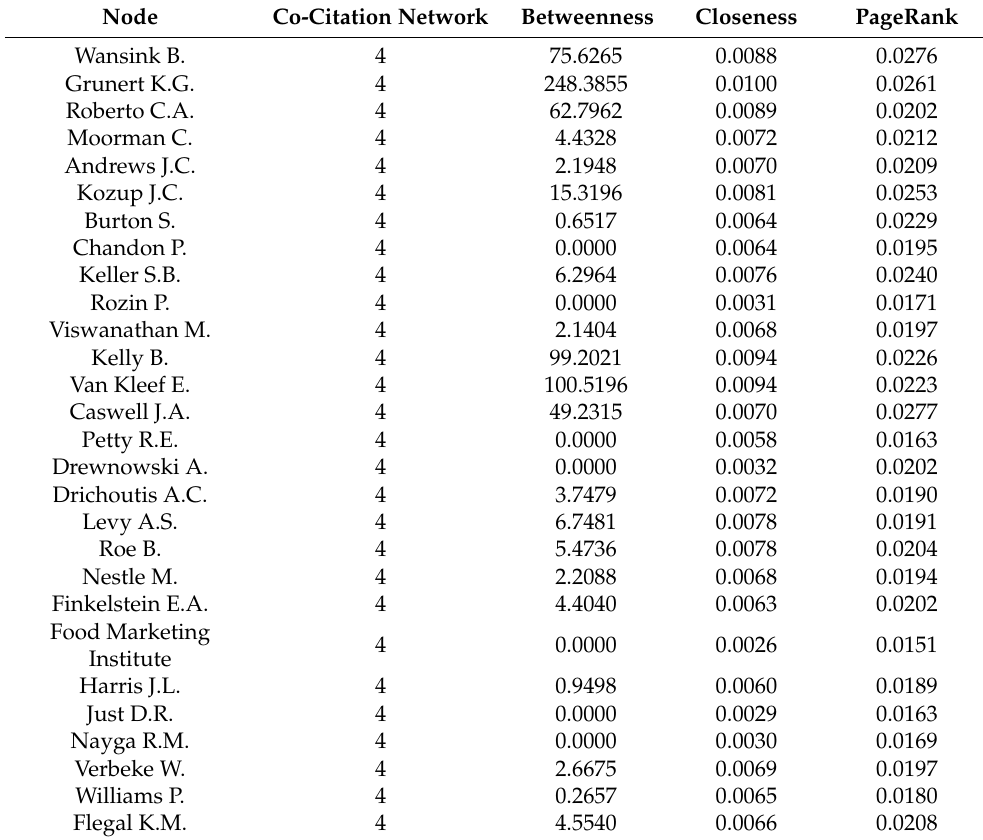
Table 11. The relative strength of the nodes within co-citation network 4. Node Co-Citation Network Betweenness Closeness PageRank Wansink